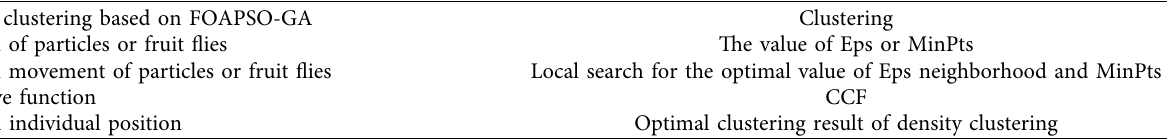
Table 1: Corresponding relationship between FOAPSO-GA and density clustering.